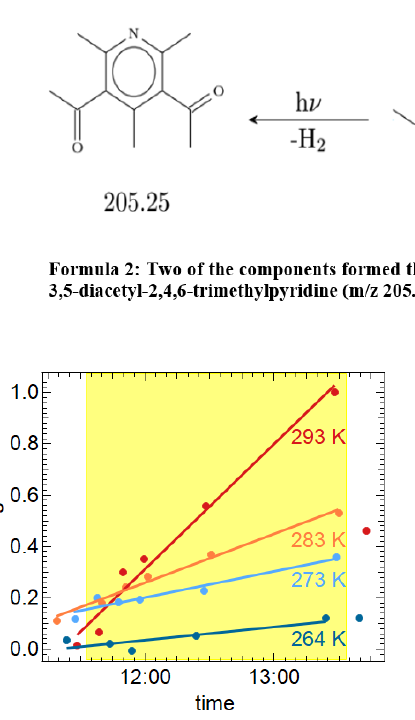
Figure 9. Mass increase over the illumination period of the mass peak at m/z 205 in the particle phase, identified as 3,5-diacetyl- 2,4,6-trimethylpyridine. Dots represent the measurement values. The formation is slower at lower